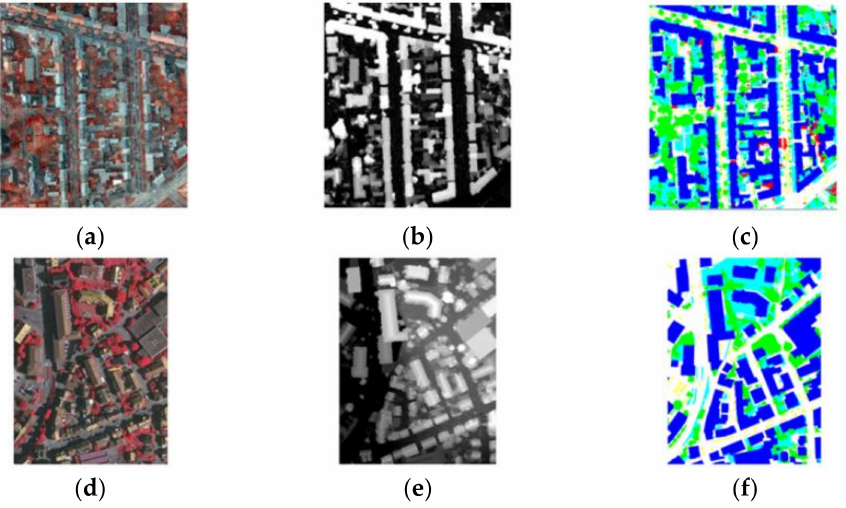
Figure 6. Sample images of Potsdam and Vaihingen datasets, digital surface models, and their corresponding labels. ( a ) Potsdam TOP, ( b ) Potsdam DSM, and ( c ) Potsdam GT, ( d ) Vaihingen TOP, ( e ) Vaihingen DSM, and ( f ) Vaihingen